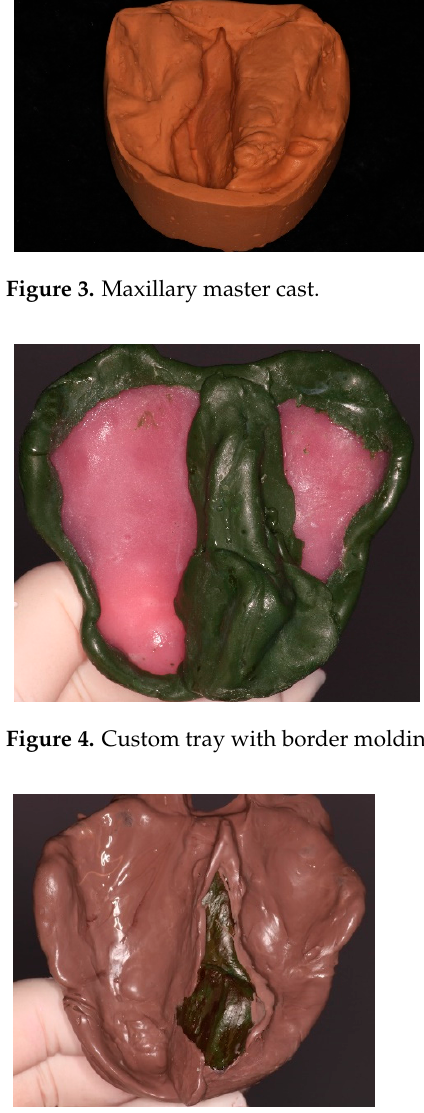
Figure 5. Final impression.